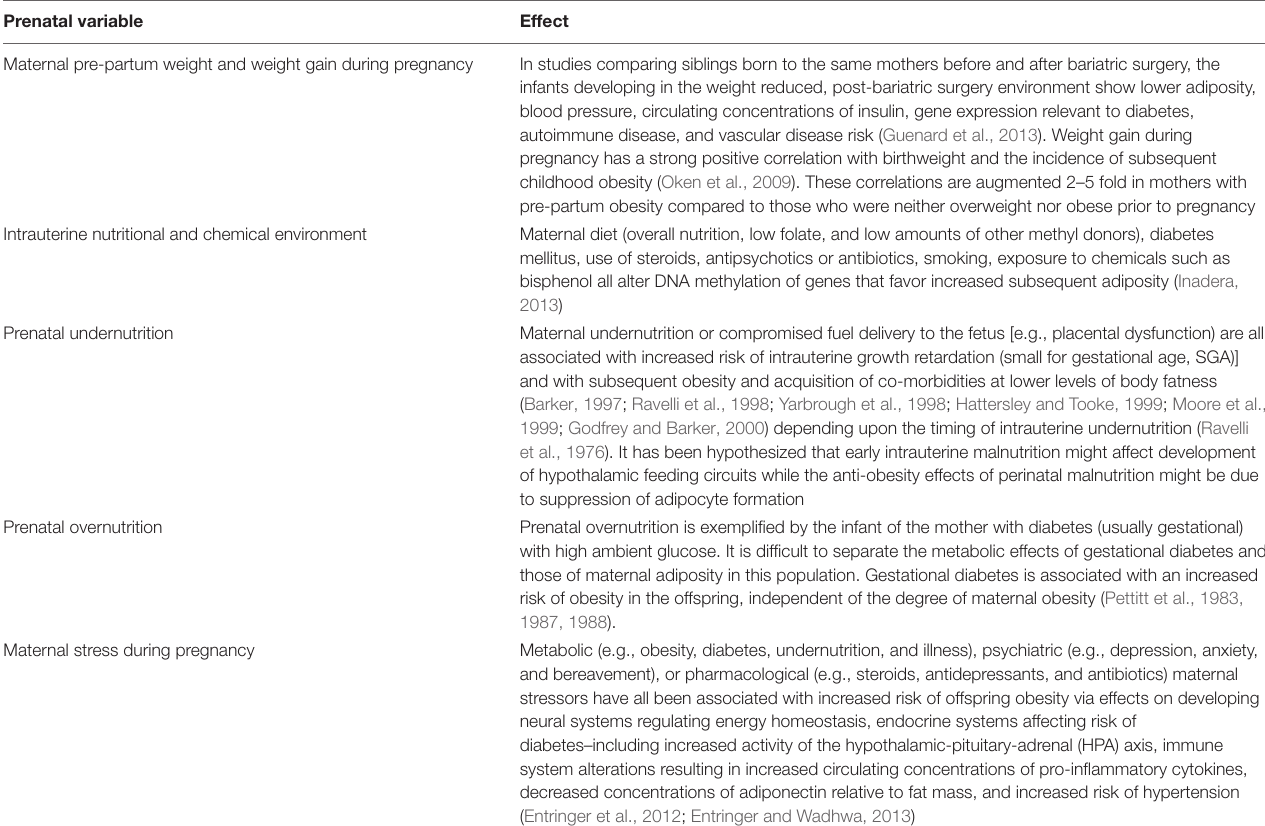
TABLE 1 | Overview of intrauterine epigenetic factors relevant to subsequent